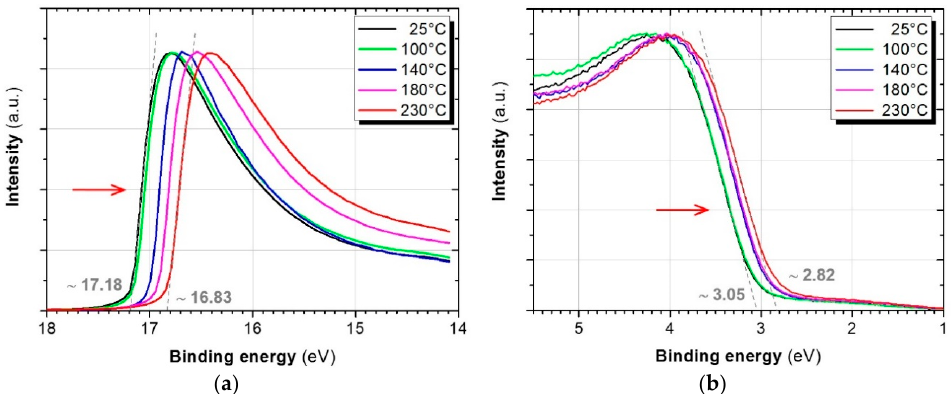
Figure 6. UPS spectra obtained for the ~150 nm thick In 2 O 3 :H 2 O films during stepwise annealing in UHV without breaking vacuum. Two regions ( a , b ) of the same spectra are shown. For comparison, the intensity was normalised and the background was removed. The excitation energy was 21.2 eV.